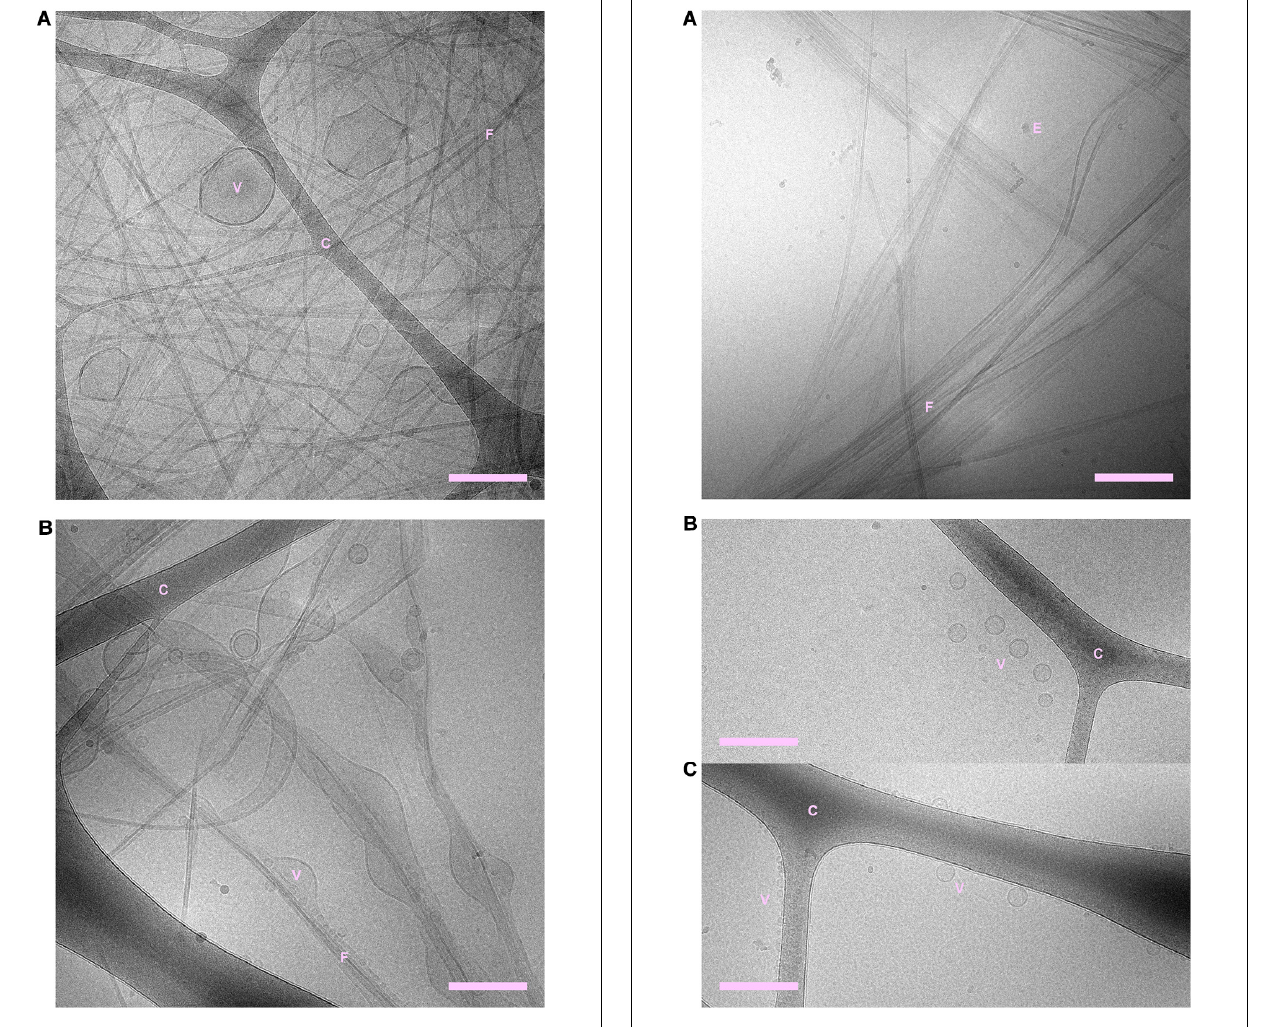
FIGURE 1 | (A) NACore fibrillated in the presence of POPC:POPS vesicles. (B) NACore fibrillated in the presence of POPC vesicles. In both cases, highly distorted and trapped vesicles can be observed among the fibrils. There are more bilayer structures relative to the number of visible fibrils in the case of NACore with POPC than with POPC:POPS. “C” denotes the cryo-TEM carbon grid, “F” denotes fibrils, and “V” denotes distorted vesicles. Scale bars show 200 nm.